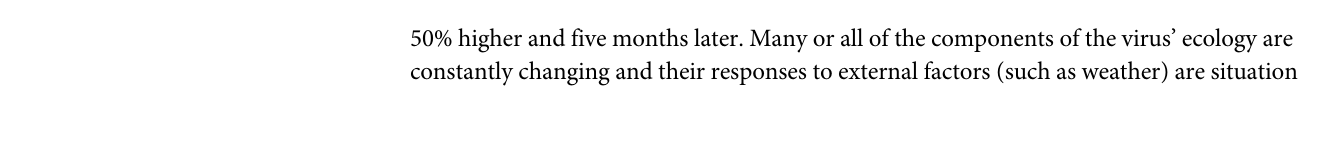
Fig 5. Average ranking of simulations using each parameter value when compared with reported case data for all years and individual years. Rankings were based on r 2 values with lower value ranks being better and higher value ranks being worse.